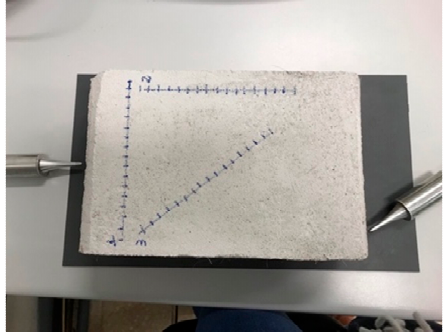
Figure 9. Modulus of elasticity by ultrasound pulse velocity. The results of modulus of elasticity by ultra-sound pulse velocity test are presented in Figure 10. It was noticed that the modulus of elasticity of the mortars with binary binder is lower than that of the reference cement mortar, at 28 days. This result suggests that the cement mortars are more compact and less porous [4] than the lime-cement ones, as expected. The fibres’ addition reduced the modulus of elasticity of the mortars, which indicates that the natural fibre-reinforced mortars are more deformable than the reference ones. This could be due to the lower modulus of elasticity of the fibres, which reduces the global modulus of elasticity of the mortars. Additionally, the incorporation of fibres required more mixing water to achieve the intended workability, which interferes in the porosity and consequently the modulus of elasticity of the mortars.